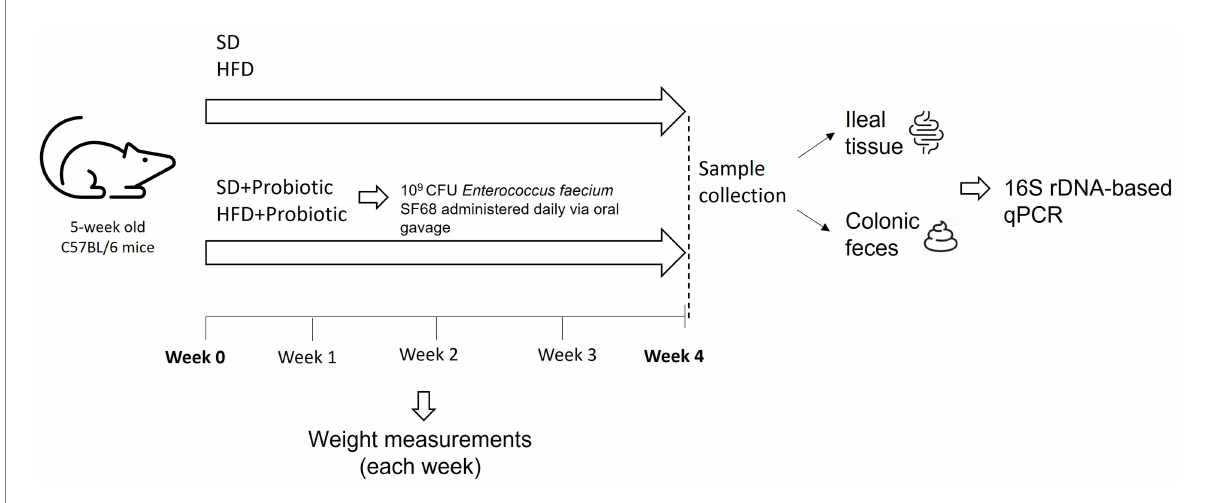
FIGURE 1 Schematic representation of the experimental